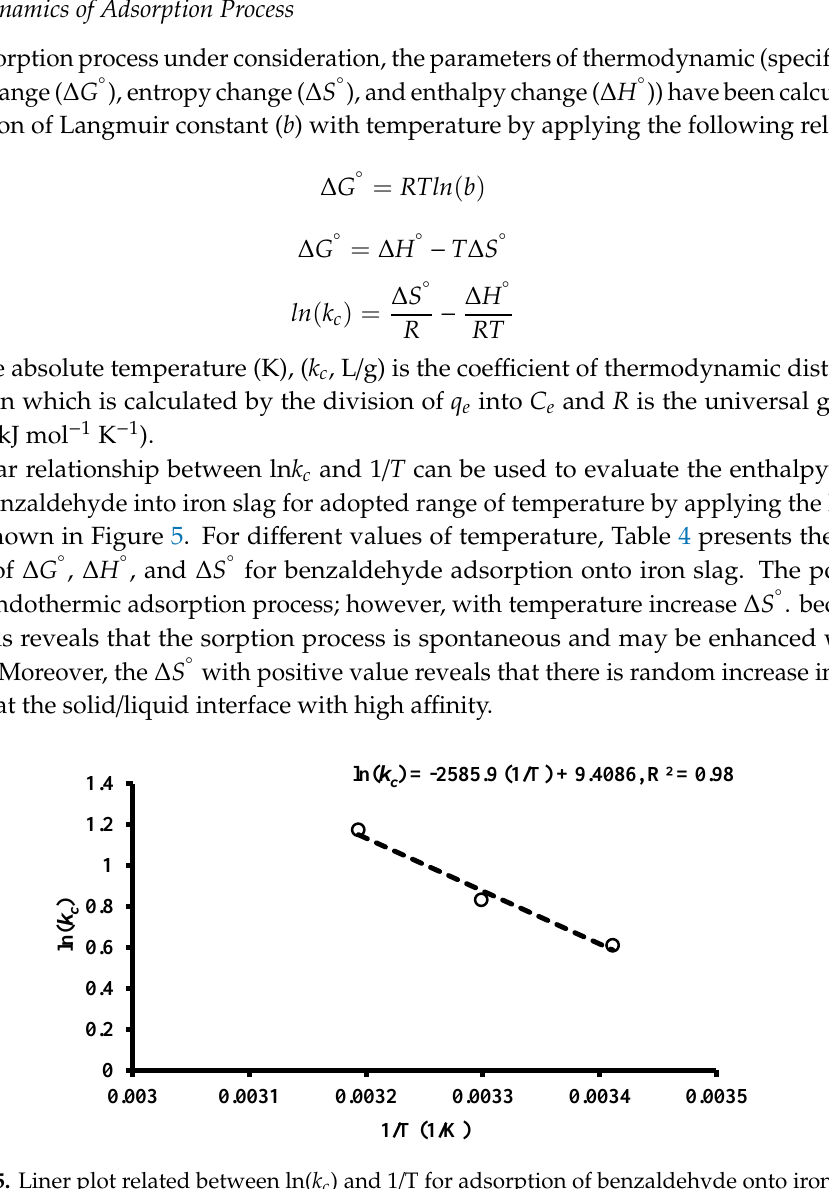
Figure 5. Liner plot related between ln( k c ) and 1 / T for adsorption of benzaldehyde onto iron slag. Table 4. Values of thermodynamic parameters for adsorption of benzaldehyde onto iron slag. Thermodynamic Parameters